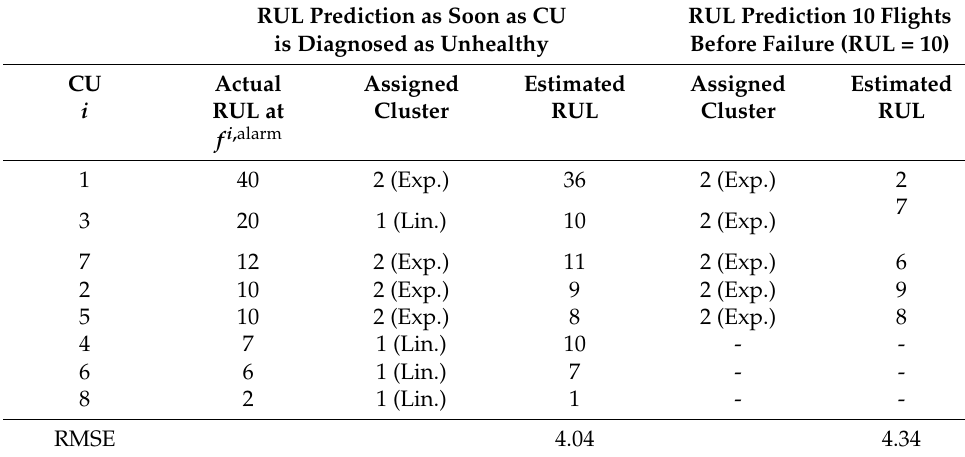
Table 2. RUL prediction (in flights) for the CUs. The RUL is estimated once the CU becomes alerted and 10 flights before failure. RUL Prediction as Soon as CU RUL Prediction 10 Flights is Diagnosed as Unhealthy Before Failure (RUL = 10) CU Actual Assigned Estimated Assigned Estimated i RUL at Cluster RUL Cluster RUL f i , alarm